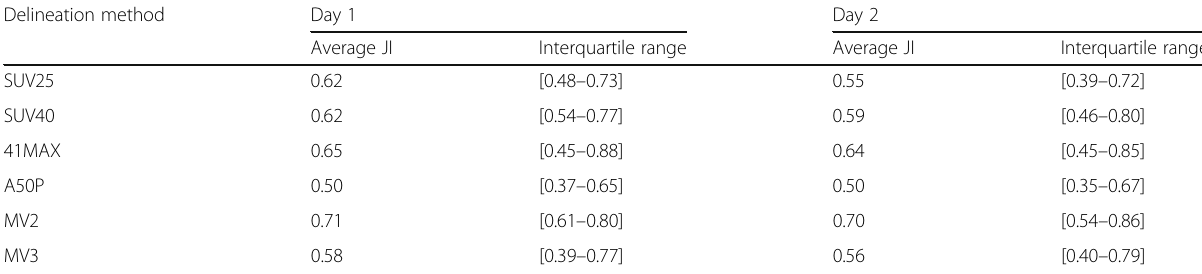
Table 2 Jaccard index and interquartile range Delineation method